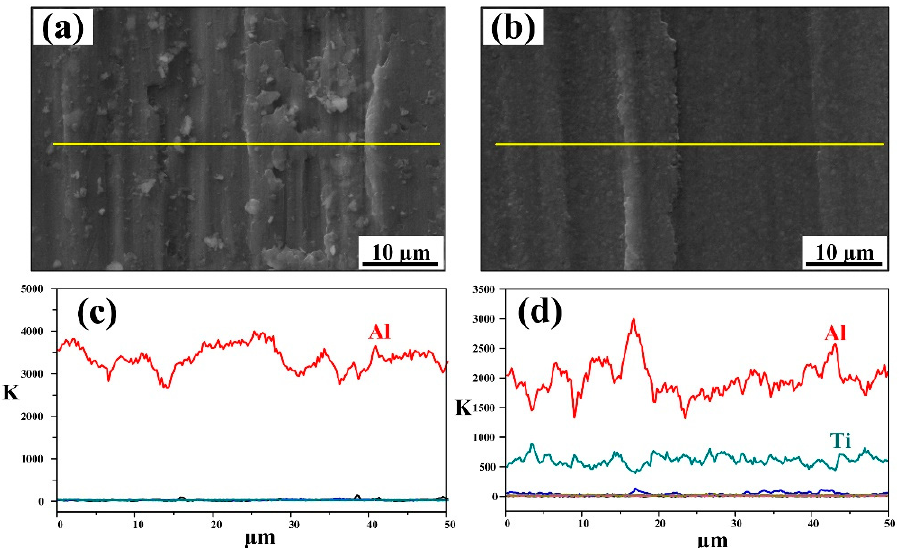
Figure 12. SEM images of worn scar and EDS results of ( a , c ) Al-4.7Cu-0.32Mg-0.44Si alloy and ( b , d ) 40 wt.% (TiC-TiB 2 )/Al-4.7Cu-0.32Mg-0.44Si composites under 5 N load and 13 µ m Al 2 O 3 abrasive size. ( c ) and ( d ) show the EDS line scanning analysis results in ( a ) and ( b ), respectively.